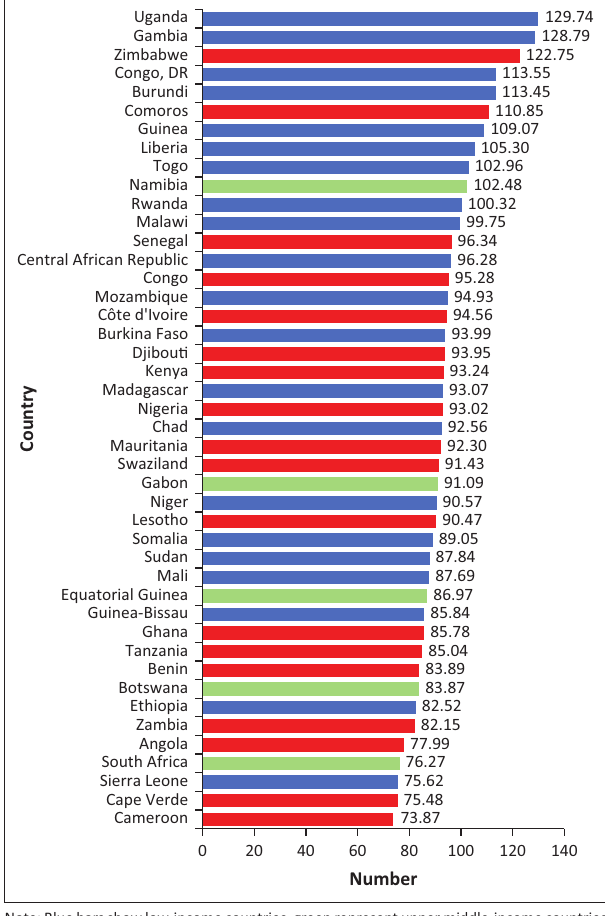
Note: Blue bars show low-income countries, green represent upper middle-income countries and red bars lower middle-income countries. * Productivity values in (‘000’). FIGURE 1: Average agricultural productivity in sub-Saharan Africa, 1990–2014. TABLE 4: World Bank classification of sub-Saharan Africa countries grouped by income